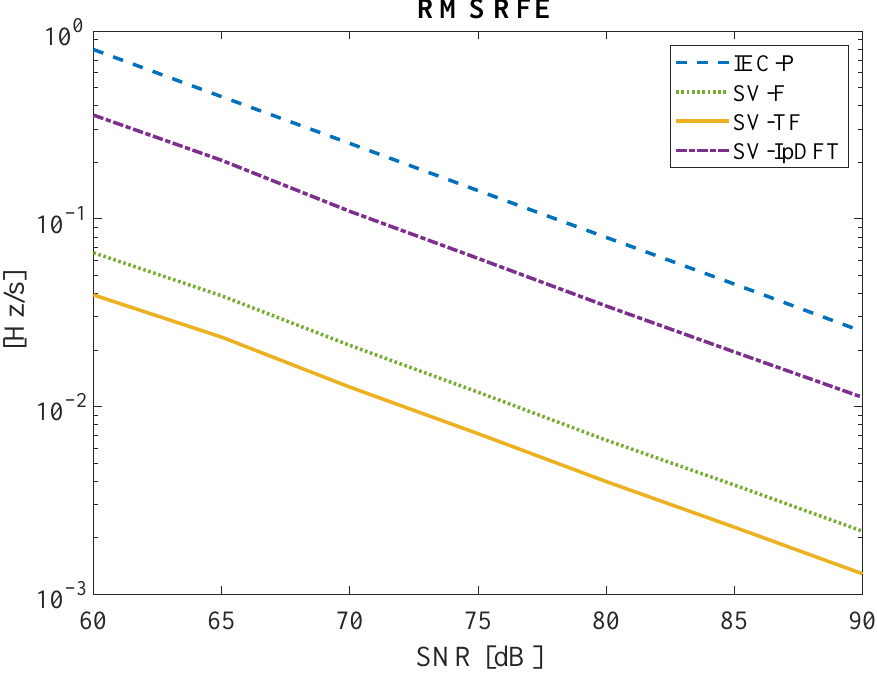
Figure 15. RMS RFE in the presence of additive wideband noise at different